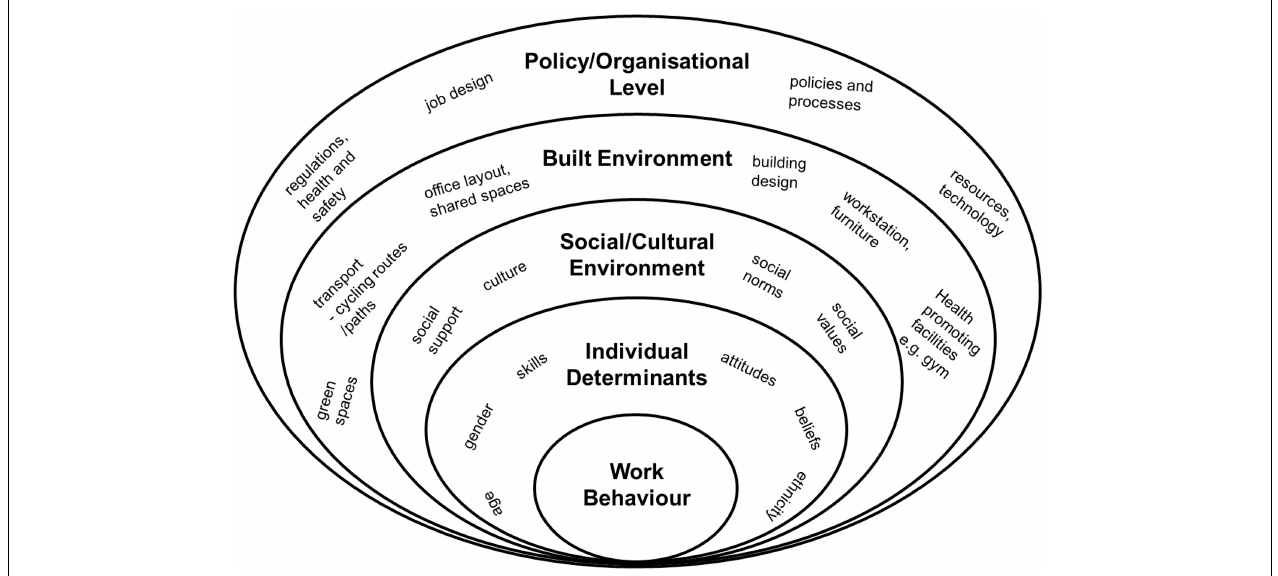
FIGURE 1 | Ecological model adapted for teleworking (Sallis et al., 2015; Munir et al., 2021).